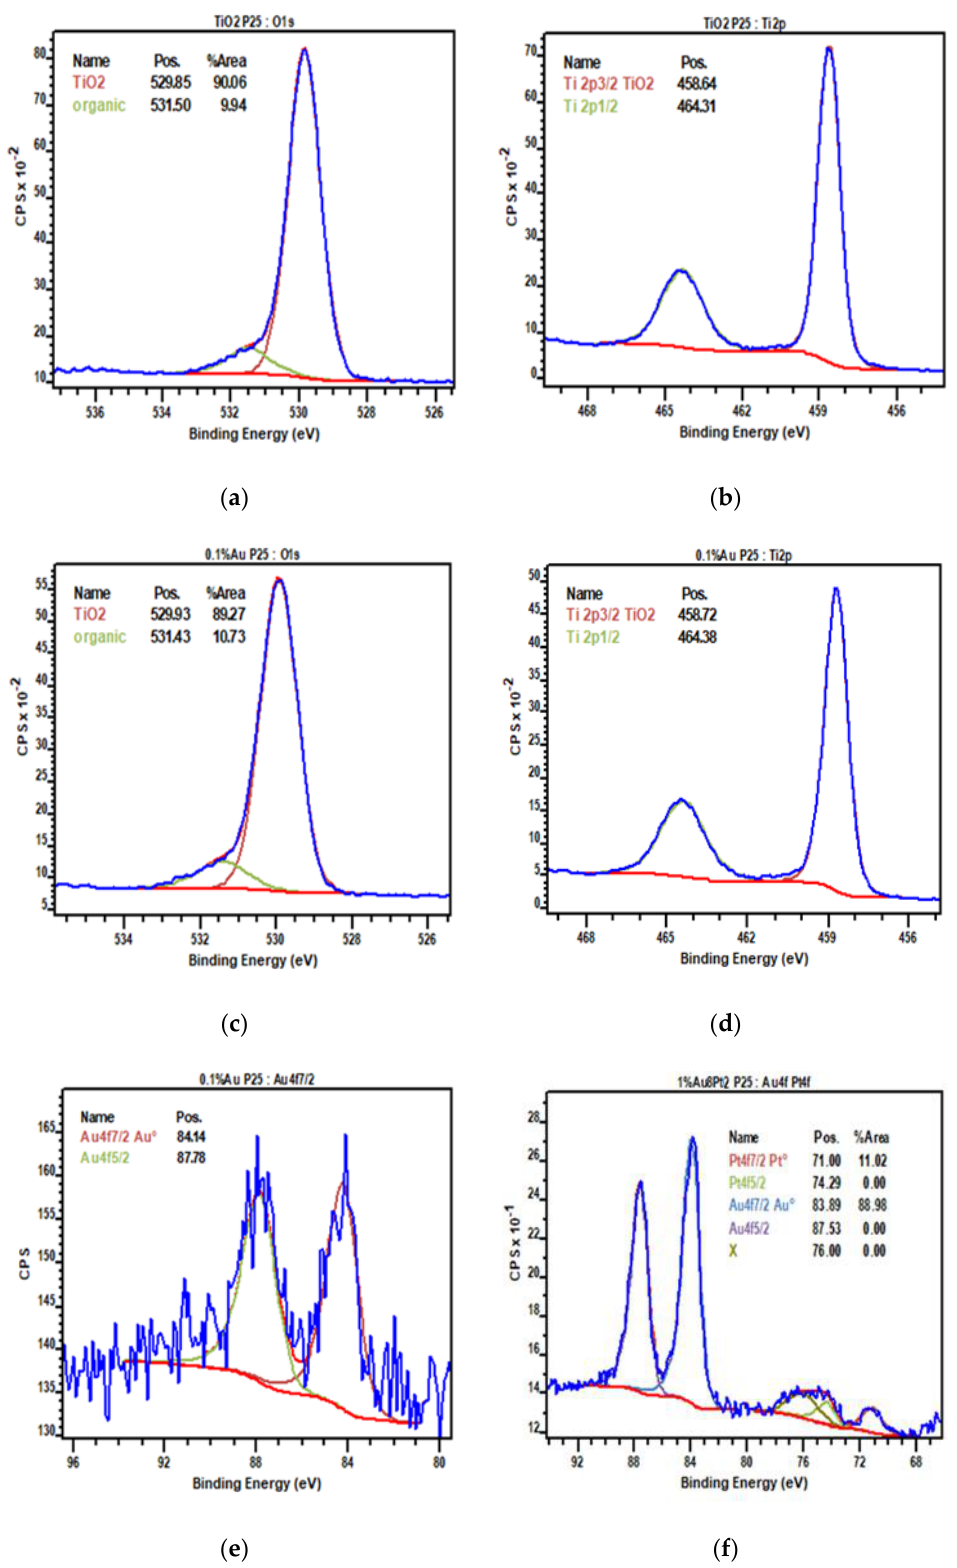
Figure 4. XPS spectra of selected photo − catalyst: ( a ) O1s P25; ( b ) Ti2p P25; ( c ) O1s 0.1 mol% Au; ( d ) Ti2p 0.1 mol% Au; ( e ) Au4f 0.1 mol% Au; ( f ) Au4f and Pt4f 1 wt% (Au 8 Pt 2 ).